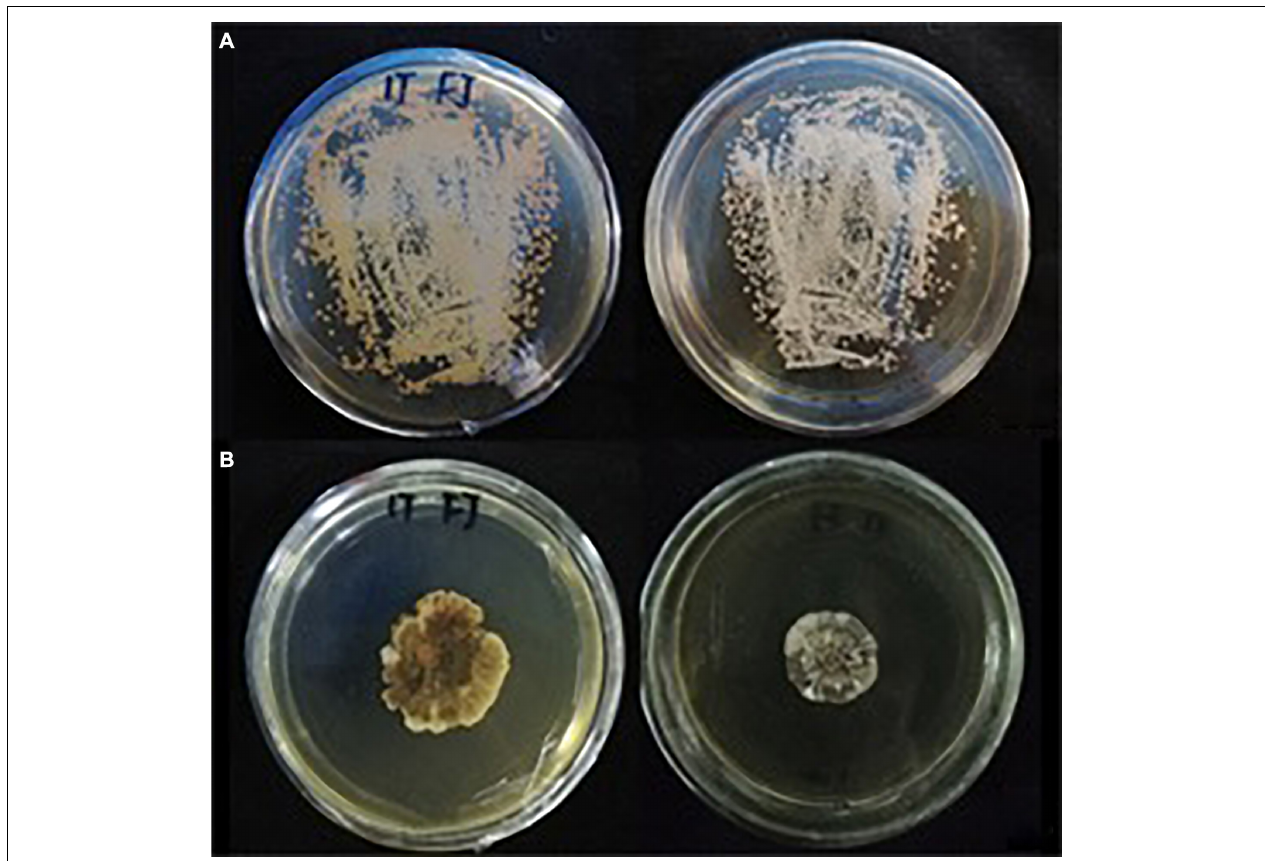
FIGURE 2 | Morphology of S. reilianum colonies growing on YEPS medium at 28 ◦ C with a 12 h light/dark cycle. (A) a small amount of teliospore suspension was distributed on YEPS medium and cultured for 10 d; (B) single colony cultured on YEPS medium for 30 d.